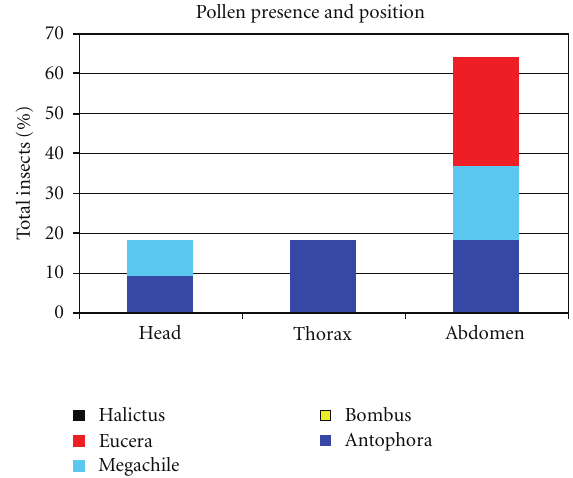
Figure 9: Presence and position of C. emerus pollen on di ff erent parts of the body of visiting insects. Data are expressed as percent of the total insects